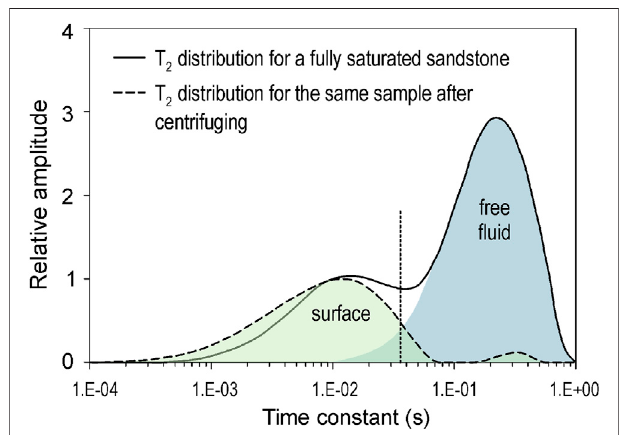
FIGURE 3 | T 2 distribution of a sandstone sample before and after extracting free fl uids (adapted from Straley et al., 1994).